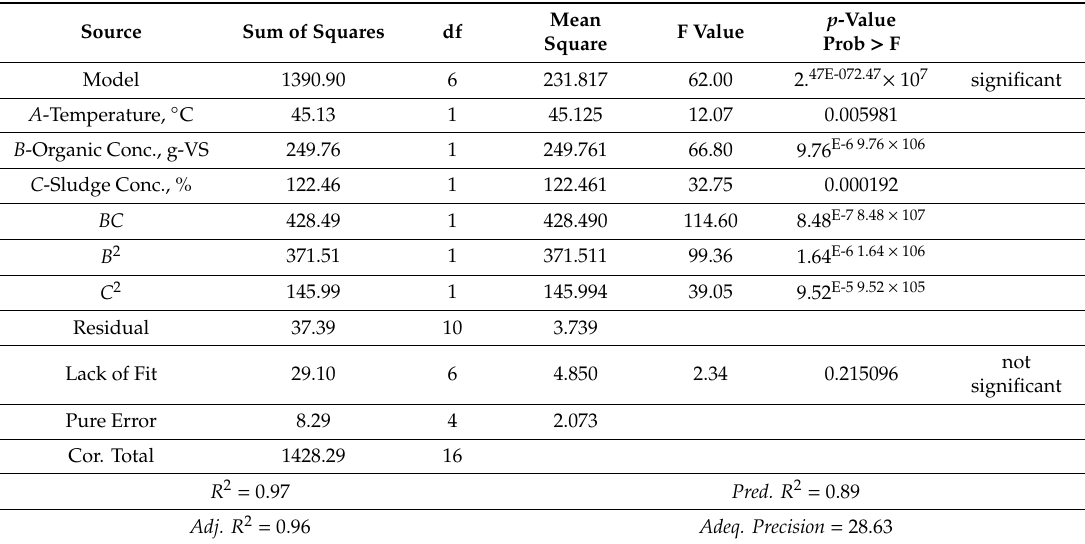
Table 8. The ANOVA table for CO 2 %